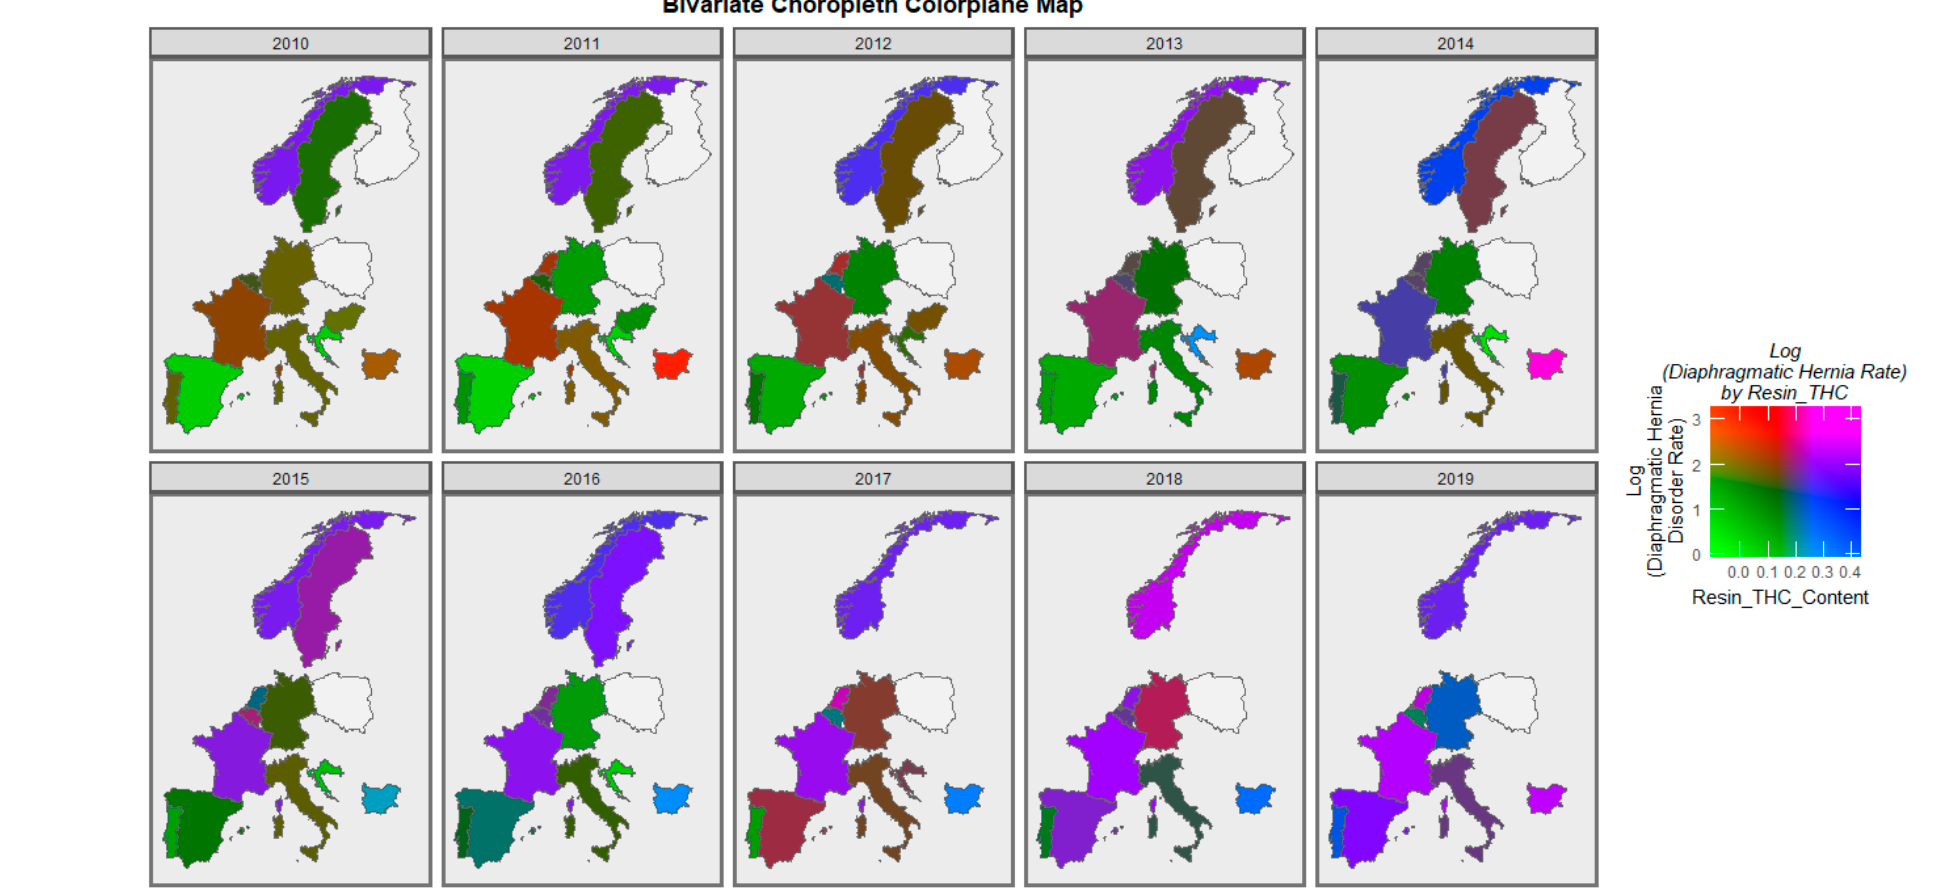
Figure 11. Bivariate colorplaner sequential map-graph of diaphragmatic hernia by cannabis resin THC concentration across selected European nations for each year of 2010–2019.